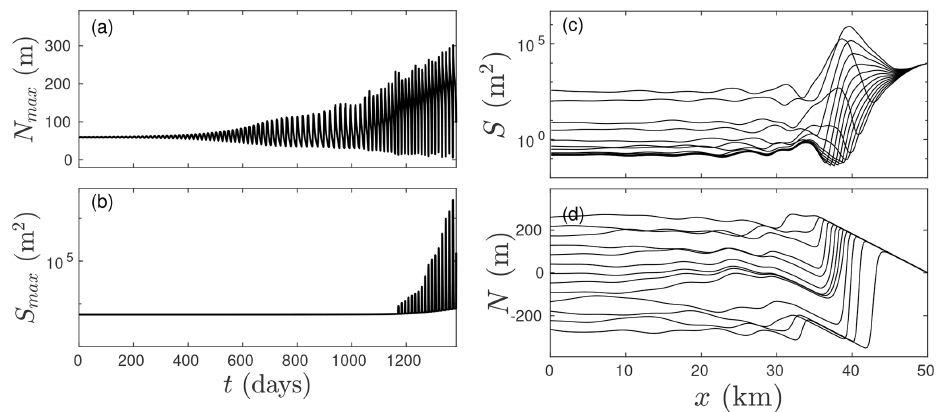
Figure 10. Finite-amplitude evolution of the instability for the magenta dot marked “D” in Fig. 8a. (a) The maximum of N(x,t) along the flow path plotted against time t . (b) The maximum of S(x,t) with respect to x plotted against t (c) snapshots of S(x,t) at intervals of 0.93d towards the end of the simulation (d) snapshots of N(x,t) at the same points in time as in (c) . Note the logarithmic vertical scale in (c) .